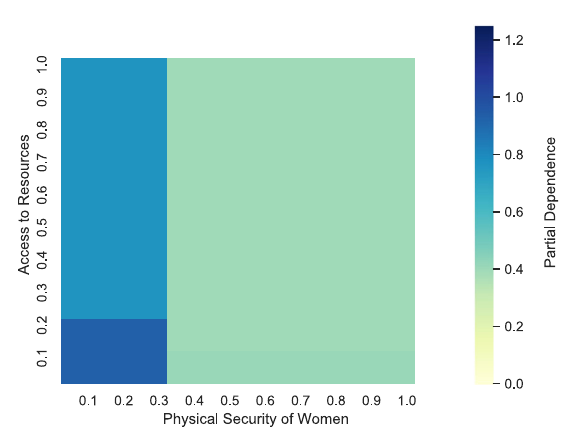
Fig. 6 A heat map illustrating that the partial dependency of the prevalence prediction of the best model is especially high when both Access to Resources and Physical Security of Women are low. Here, a lower score for Physical Security of Women indicates less security.